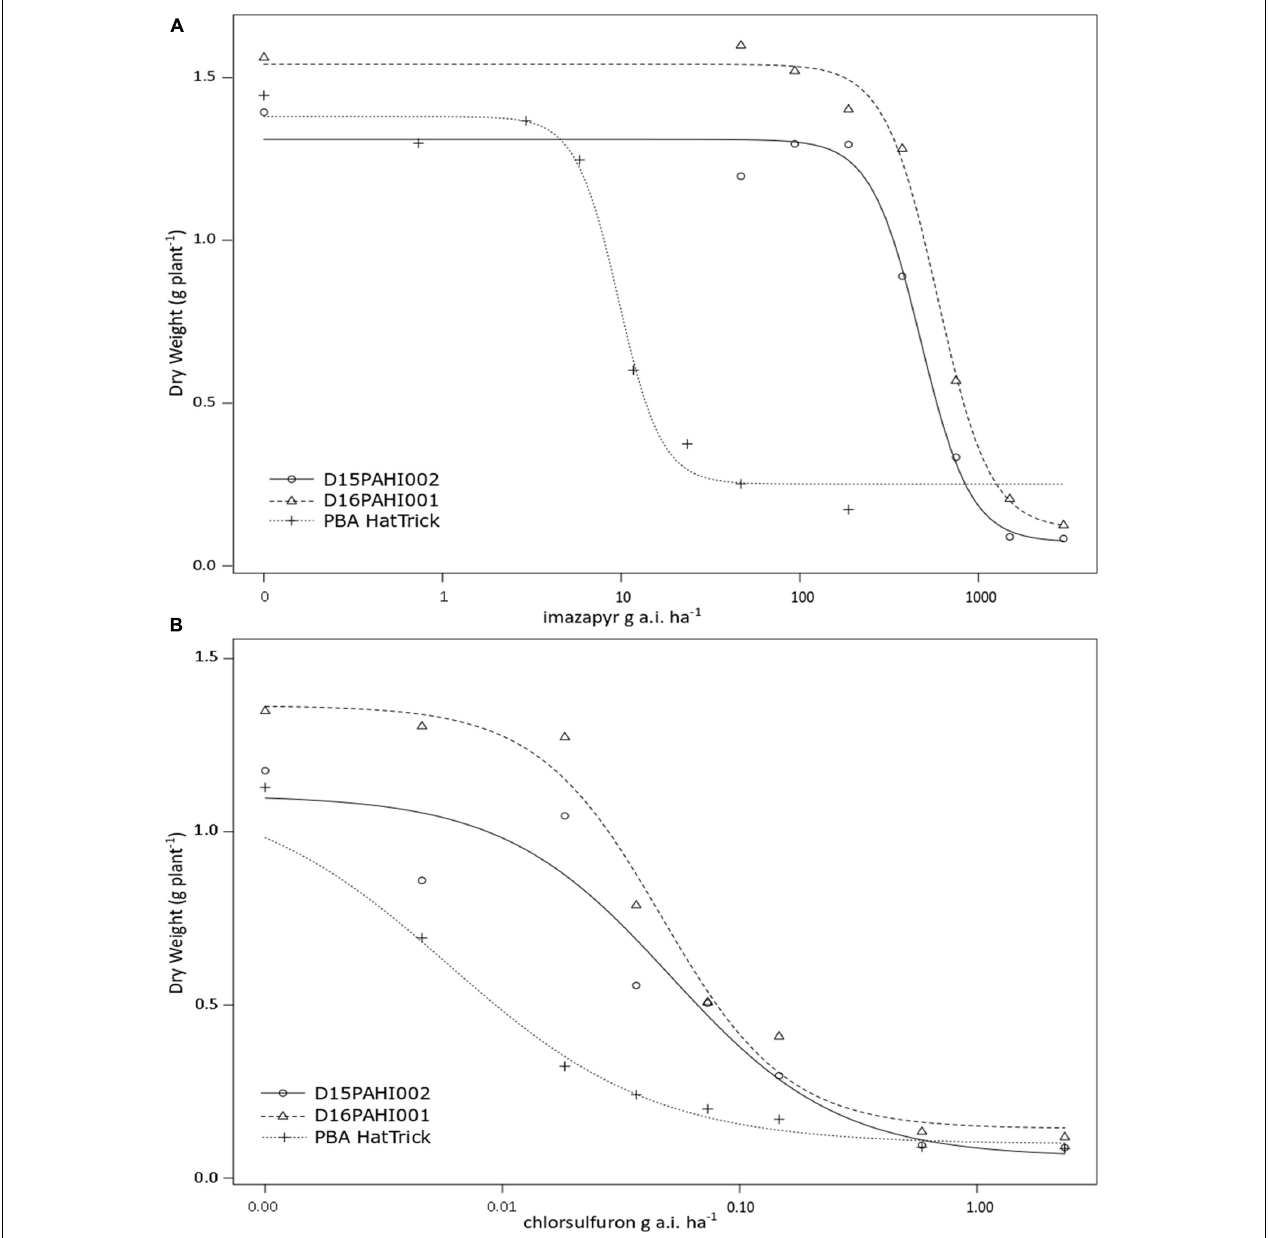
FIGURE 2 | Plant dry weight response at 21 days after treatment to increasing rates of imazapyr (A) or chlorsulfuron (B) of two mutant lines D15PAHI002 and D16PAHI001 and reference check; the mutant’s background cv. PBA